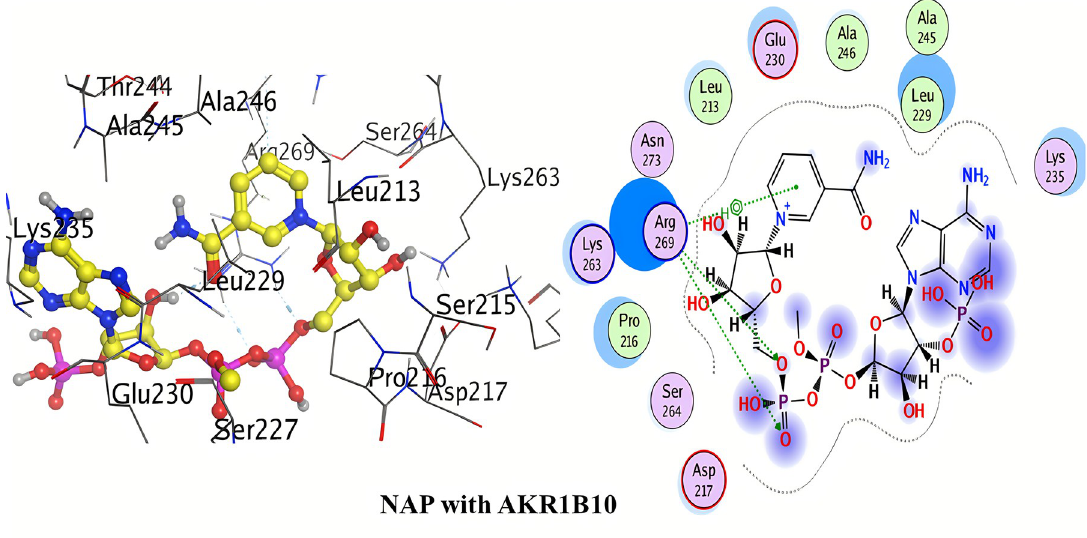
Fig 7. 3D and 2D interactions of Nap (co-crystal ligand) with active site of AKR1B10.